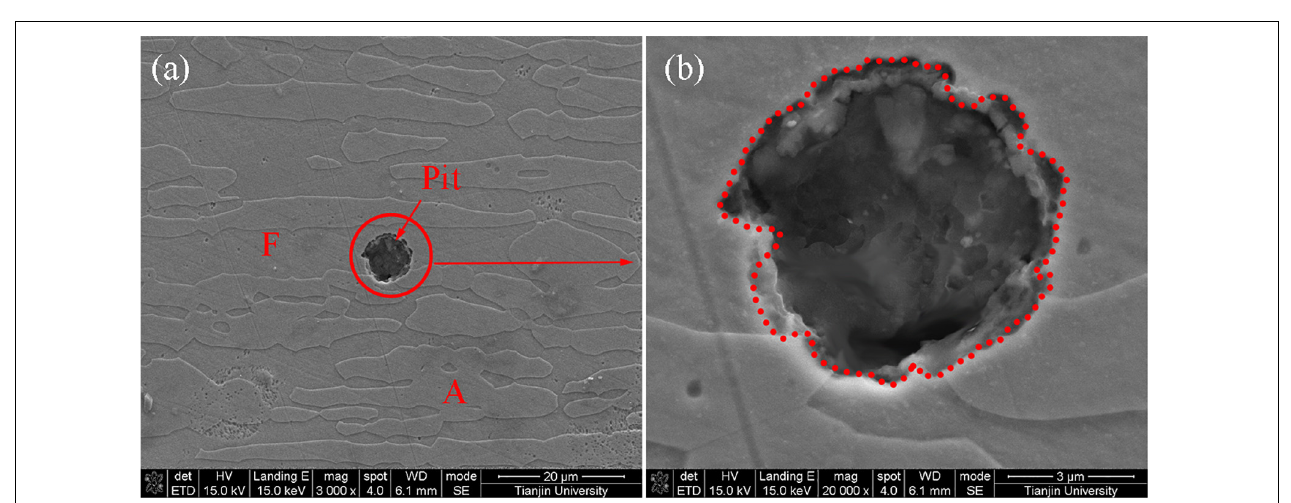
FIGURE 7 | The typical curves of the current density against temperature obtained by the potentiostatic polarization tests in 1 M NaCl solution.